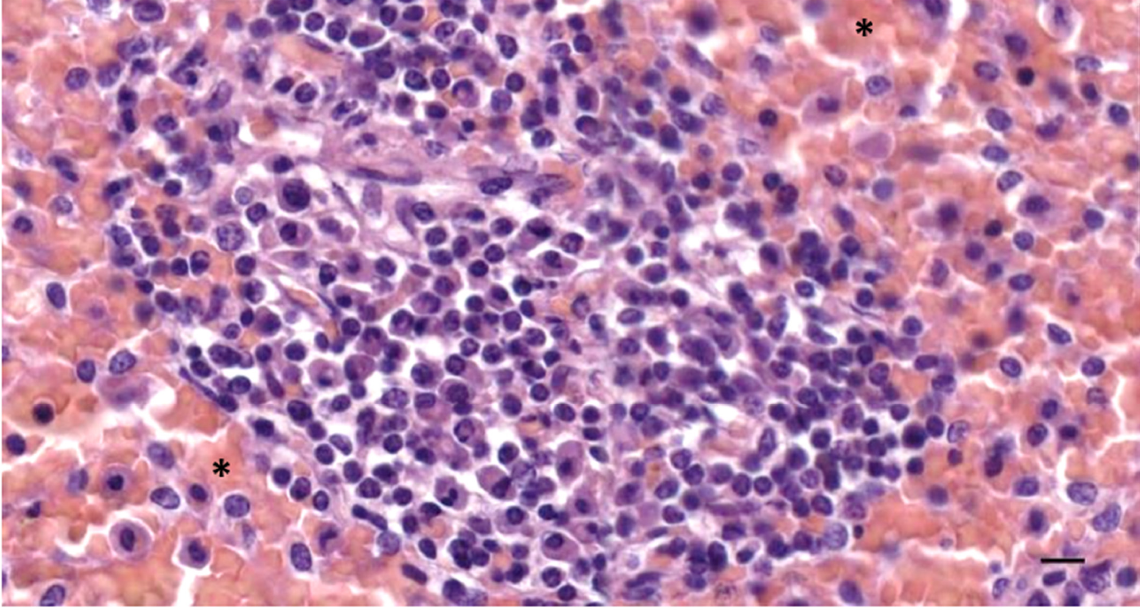
Figure 12. A histological image (HE stain) (274/18_R9). Patched follicle tissue and the intense presence of red blood cells (asterisks). Scale bar = 10 µm.